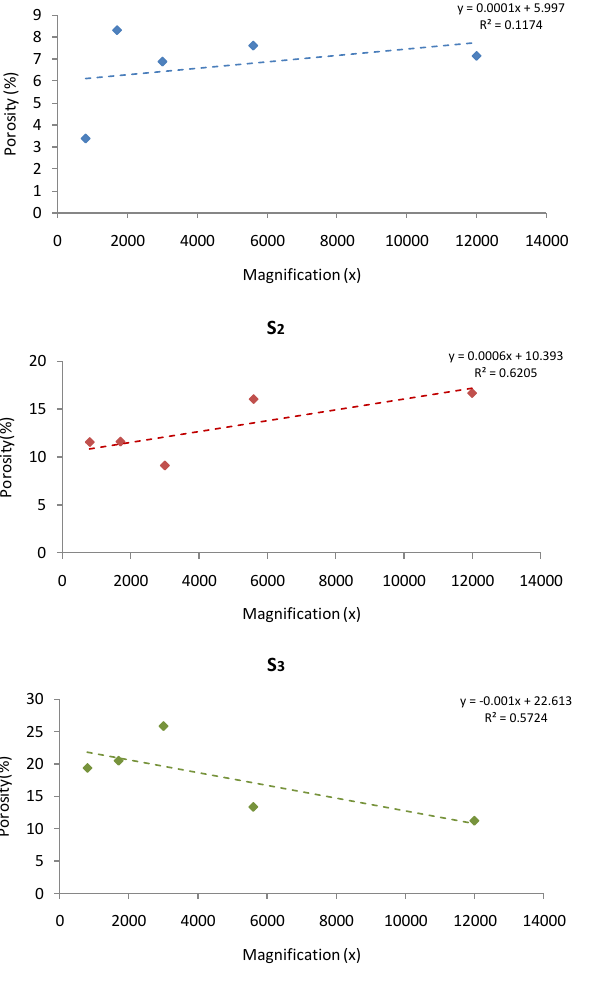
Figure 15. Magnification effect on porosity: Porosity estimation for samples S 1, S 3 and S 3 for 4 Fig. 15. Magnification effect on porosity: Porosity estimation magnifications between 800x and 12000x. 5 for samples S 1 , S 3 and S 3 for magnifications between 800x and